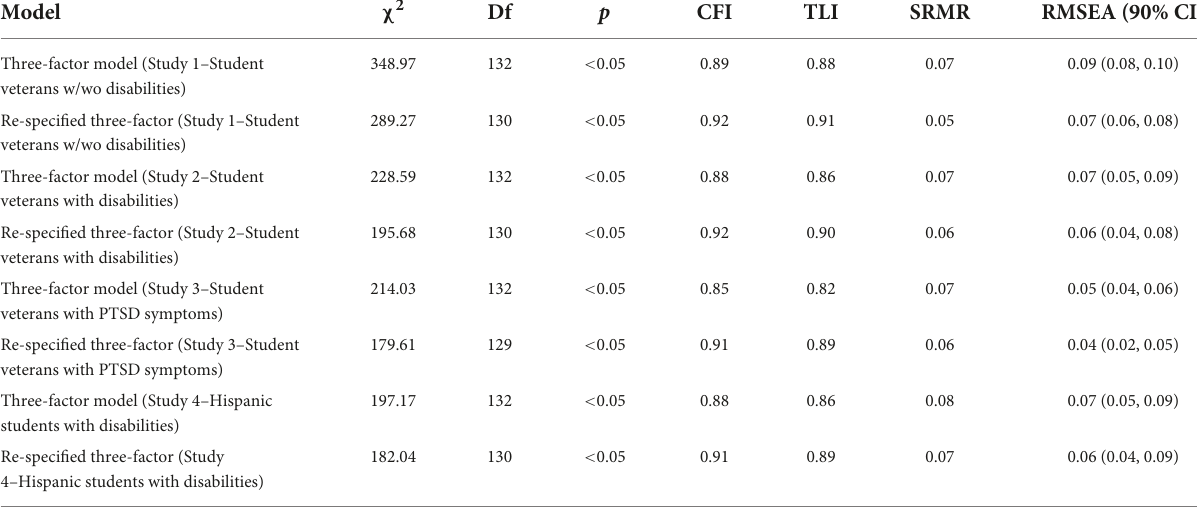
TABLE 4 Confirmatory factor analysis (CFA) findings.